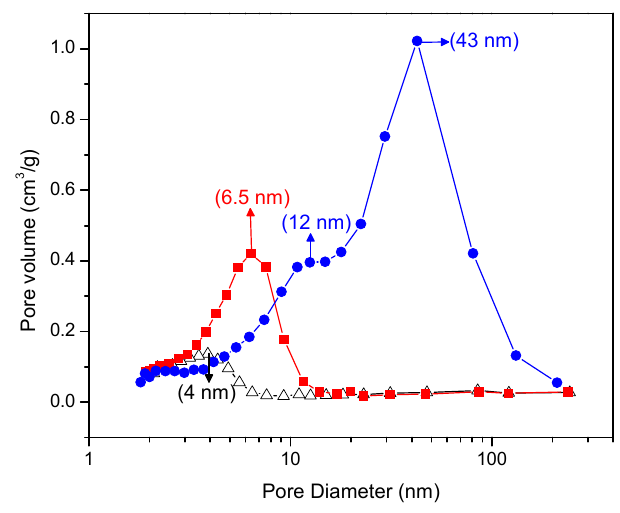
Figure 5. Pore size distribution of the Pt–TiO 2 prepared via incipient wetness impregnation; ( ● ) mesoporous TiO 2 thermally treated at 550 °C (Guayaquil et al. [10] (sol-gel B), ( ■ ) mesoporous TiO 2 calcined at 450 °C (sol-gel A), ( Δ ) Degussa P25 impregnated with 1.00 wt. % Pt and calcined at 450 °C. The band gap energy can be estimated using the Kubelka–Munk equation and the Tauc plot, as described in Guayaquil et al. [8]. Figure 6 reports the Tauc plots for sol-gel materials with different platinum loadings.